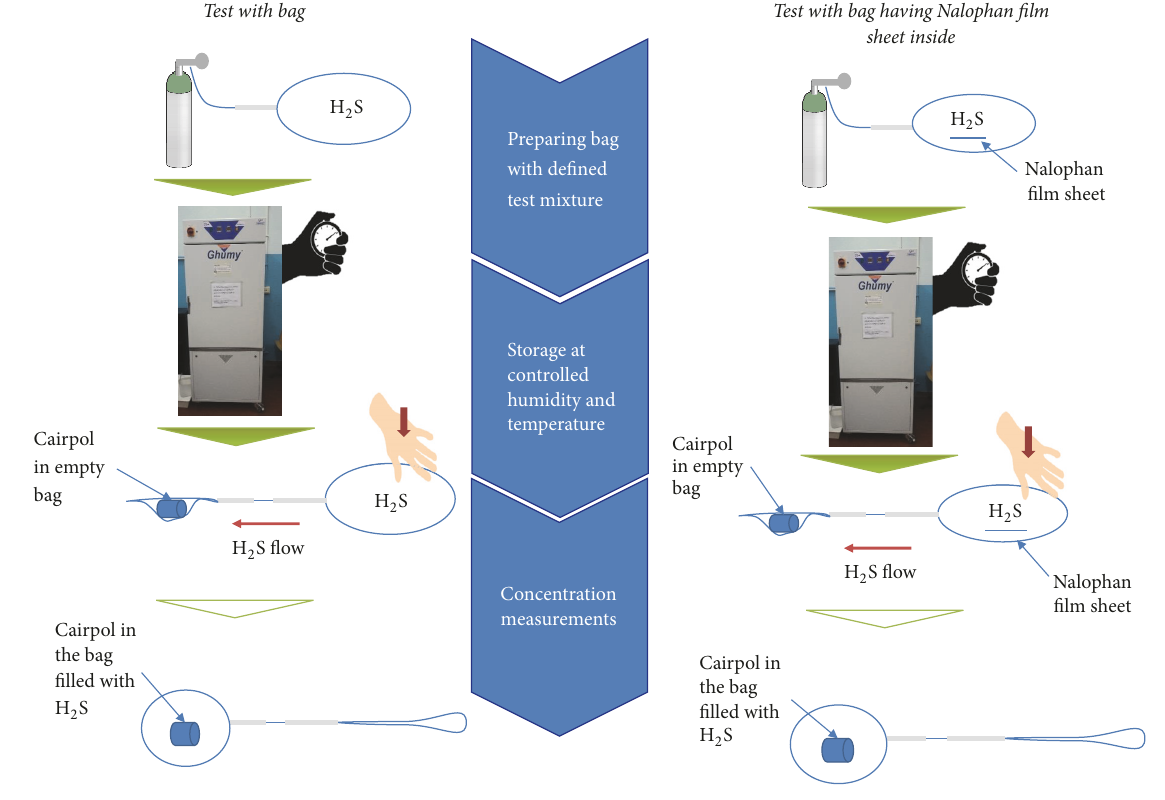
Figure 2: Scheme of the method